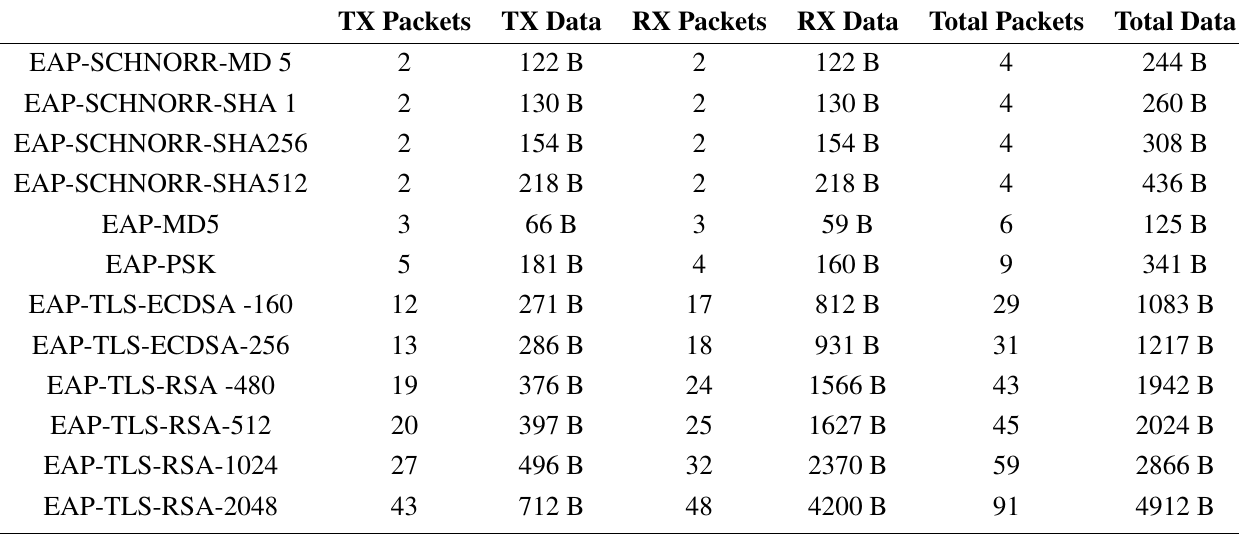
Table 1. Network usage statistics of different Extensible Authentication Protocol (EAP) methods of EAP communication, calculated on the MSP430 node connecting to the NXP/Jennic 5148, during the authentication procedure. TLS, Transport Layer